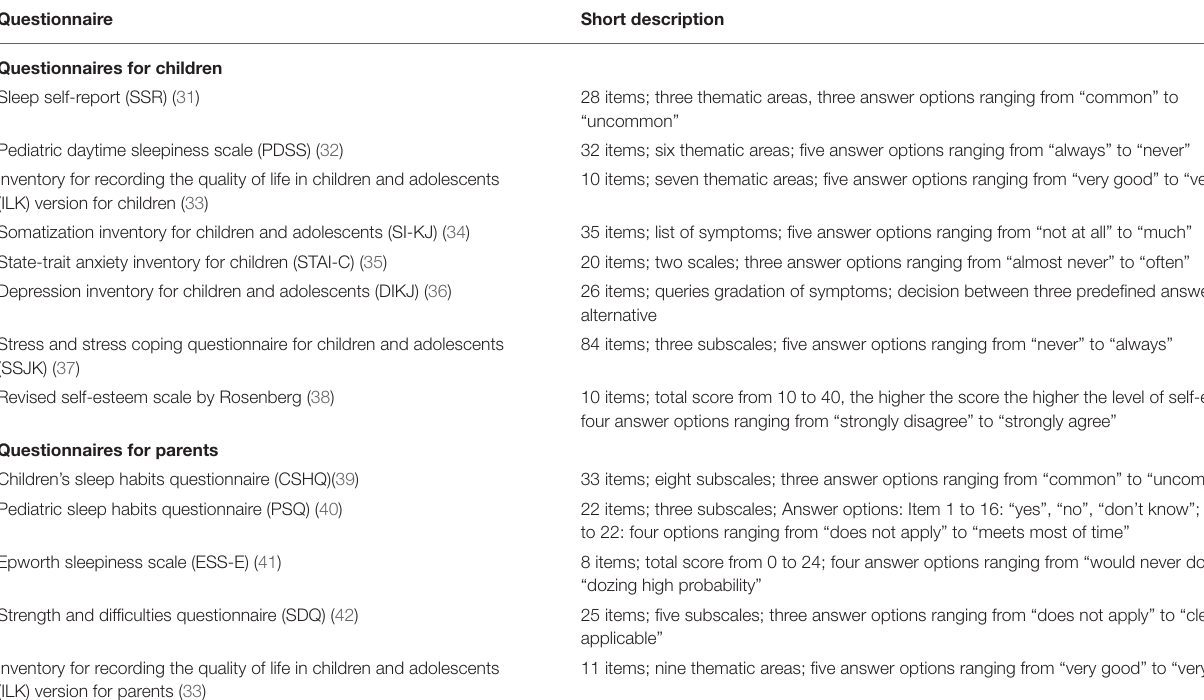
TABLE 1 | Questionnaires to assess sleep and psychological